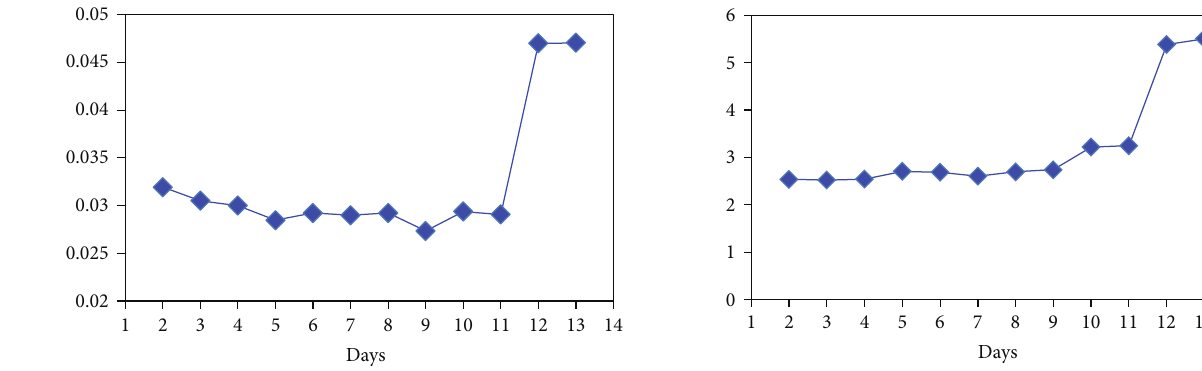
Figure 14: Crest Factor value during the test for all days.